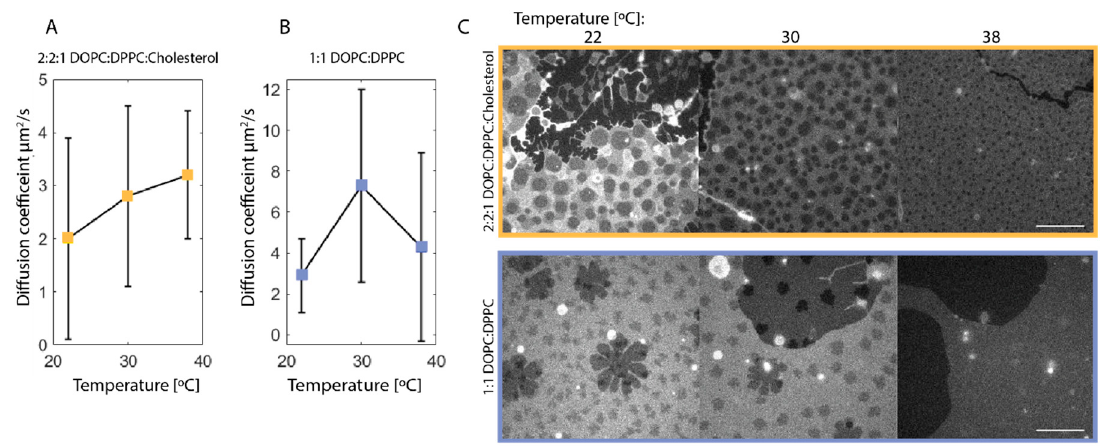
Figure 2. ( A , B ): Di ff usion coe ffi cient of NBD-PC in synthetic membrane extracted from line FRAP with the multi-component function in Equation (3) at 22 ◦ C ( A : n = 12, B : n = 12), 30 ◦ C ( A : n = 10, B : n = 3), and 38 ◦ C ( A : n = 4, B : n = 12), where n is the number of line scans. Note that the y-axis varies between ( A , B ). Error bars indicate standard deviation. There is an increase in di ff usion coe ffi cient with an increasing temperature for the 2:2:1 DOPC:DPPC:Cholesterol membrane. For the 1:1 DOPC:DPPC synthetic membrane, there is no clear tendency in terms of increasing temperature, which is likely due to the heterogeneity of the membrane type, as seen in ( C ). ( C ): Confocal images of the synthetic membranes at 22, 30 and 38 ◦ C. Top: 2:2:1 DOPC:DPPC:Cholesterol synthetic membrane showing a homogeneous distribution of domains and a reduction in the total domain area with increasing temperature. Bottom: 1:1 DOPC:DPPC synthetic membrane shows a similar reduction in domain area; however, the membrane is heterogeneous with gel formation. It appears, however, that the gel phase has disappeared at 38 ◦ C. The scalebar is 10 µ